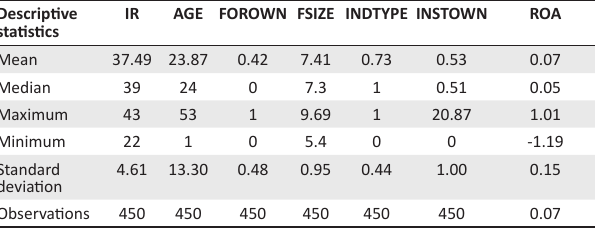
TABLE 3 : Descriptive statistic results on company attributes and integrated reporting of sampled companies in